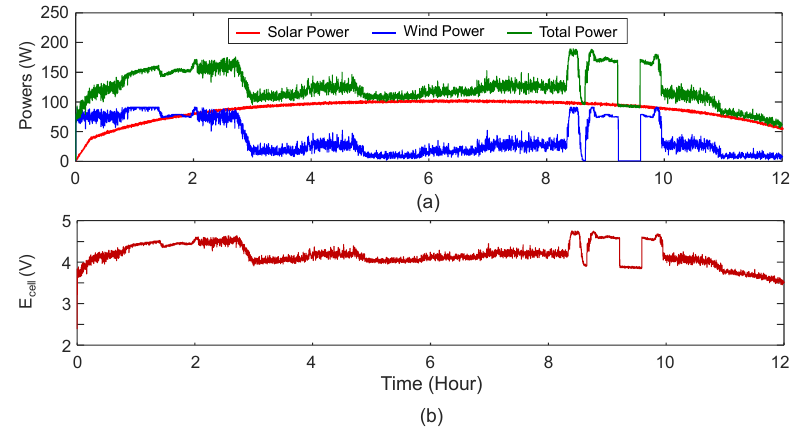
Figure 23. ( a ) Powers consumed by the cell for 12 h run and ( b ) Input voltage for the cell running on intermittent sources.